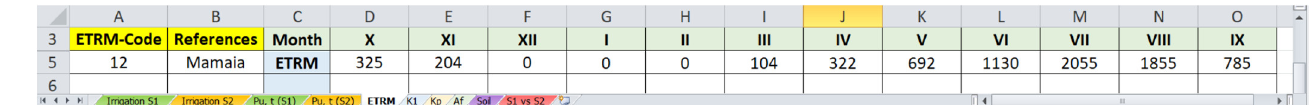
Figure 14. Comparison of the results for CT and TL (from the worksheet “S1 vs. S2”).